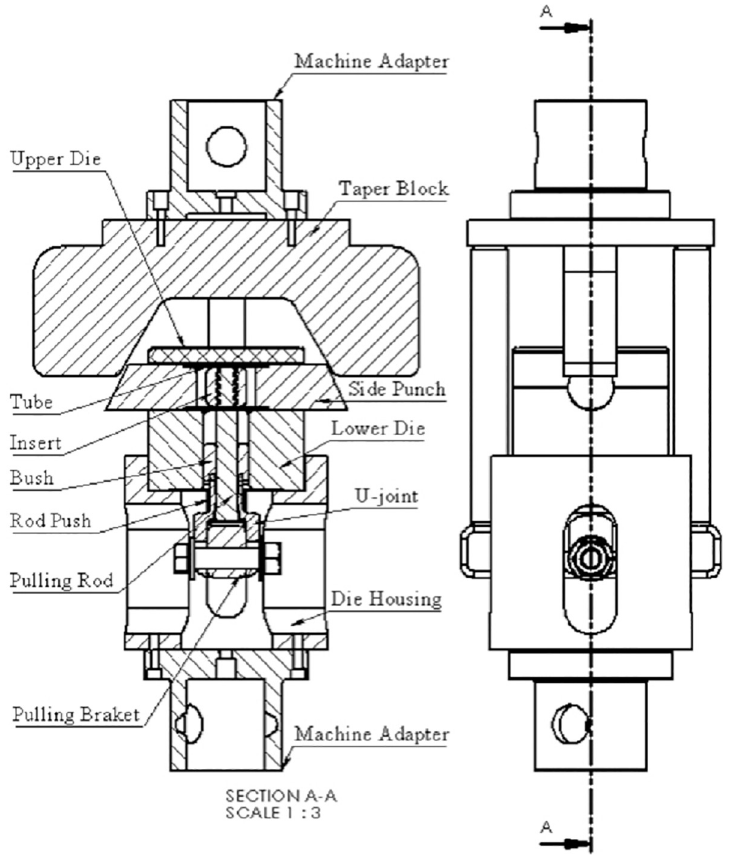
Fig 4. Die set detailed assembly drawing.